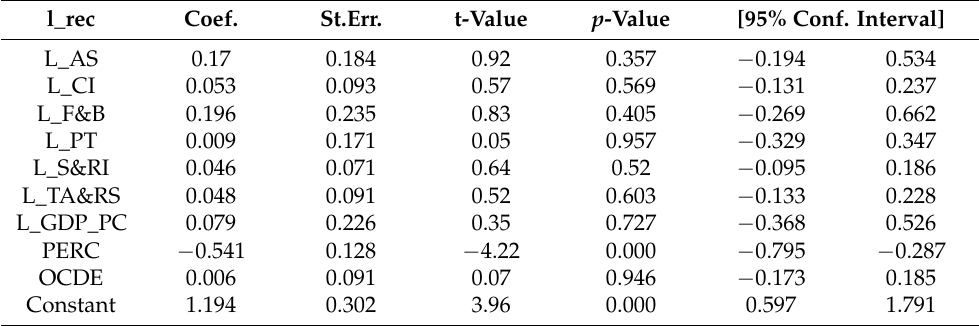
Table A8. Panel data estimations of the explanatory variables of tourism receipts (in logarithm) for the countries in the sample. Fixed effects panel with AR.